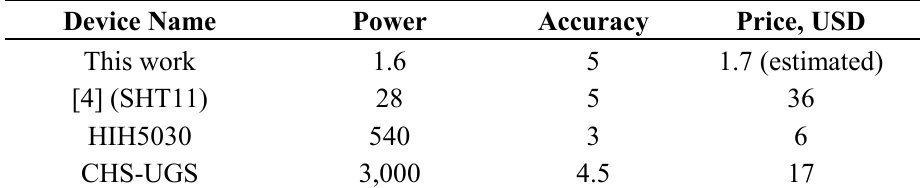
Table 2. Comparison of the Humidity